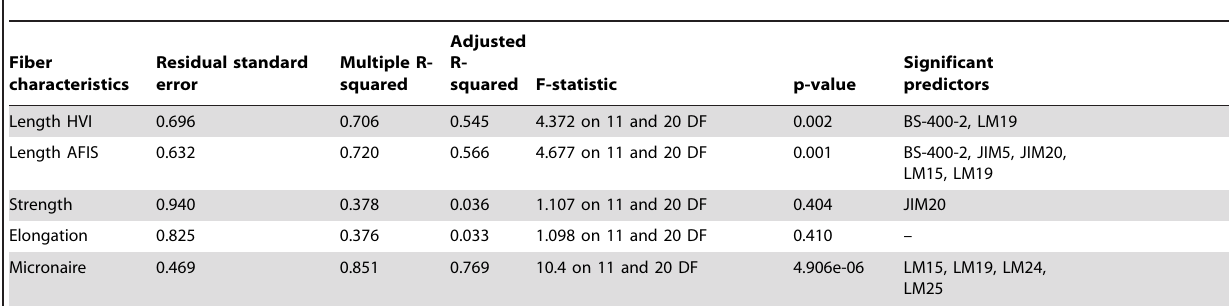
Table 2. Summary statistics of the five possible multiple regression